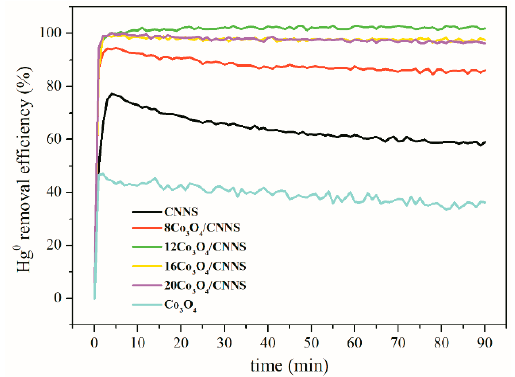
Figure 8. The Hg 0 capture performances of pure and Co 3 O 4 -modified CNNS.